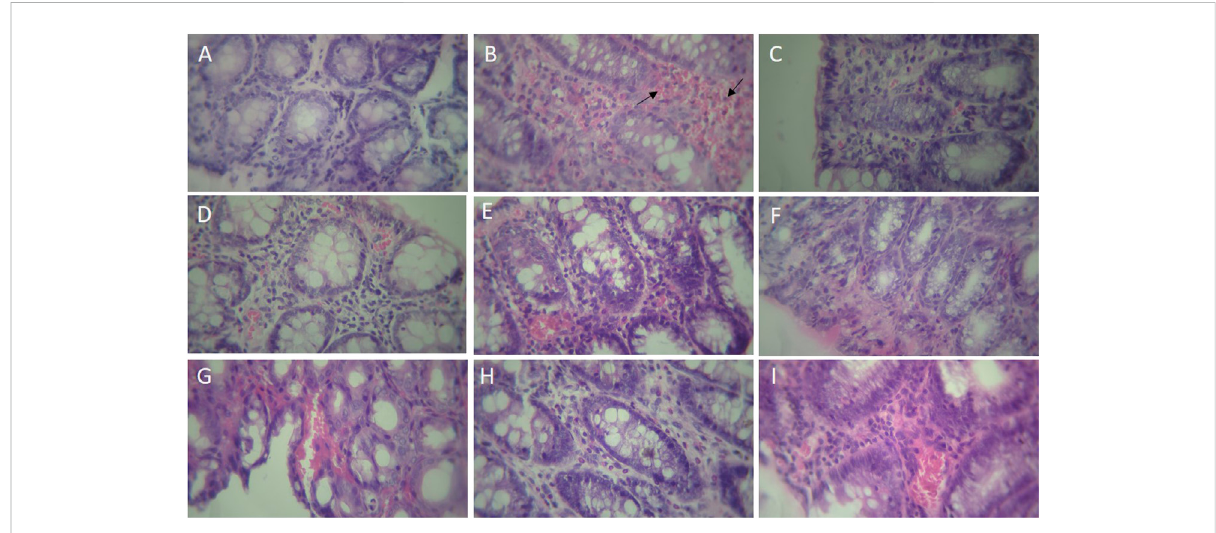
FIGURE 6 Histopathological examination of rat ’ s colonic tissue (magni fi cation, × 400). Photomicrographs of hematoxylin and eosin-stained paraf fi n sections of rat colonic tissues (A) Sham; (B) acetic acid group, which shows ulceration with necrosis (arrow) of the entire wall or part of it, transmural in fl ammation, and irregular villous mucosal surface (C) montelukast (20 mg/kg), which attenuates the extent and severity of the histological signs of cell damage (D) Mon 20 + L-arg; (E) Mon 20 + L-NAME (F) Mon 20 + sildena fi l (sil) (G) Mon 20 + Methylene blue (MB) (H) Mon 20 + diazoxide (Diaz) (I) Mon 20 + glibenclamide (Gli).